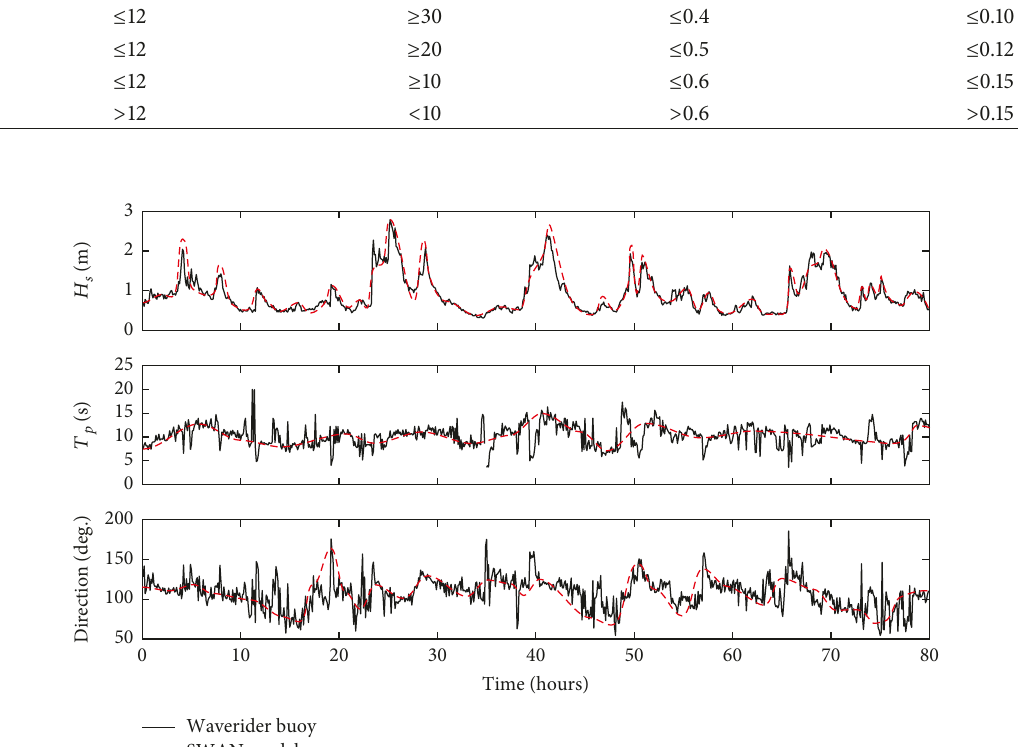
Figure 5: Comparisons between measured and predicted wave time series showing H